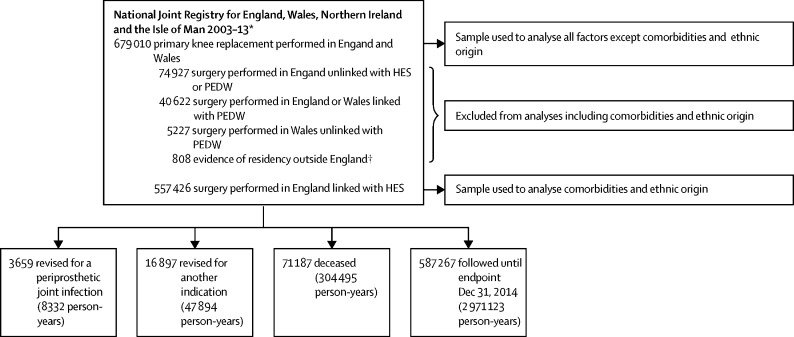
Study sampleHES=Hospital Episode Statistics for England. PEDW=Patient Episode Database for Wales. *In this research, only data for England and Wales were considered; data collection for Northern Ireland commenced on Feb 1, 2013, and primary and revision procedures from this country could not be considered because of their low number and short follow-up. Data collection for the Isle of Man commenced on July 1, 2015, which was after the endpoint of the study and therefore these data were not considered. †As recorded in HES for the 5 years preceding the primary knee replacement.